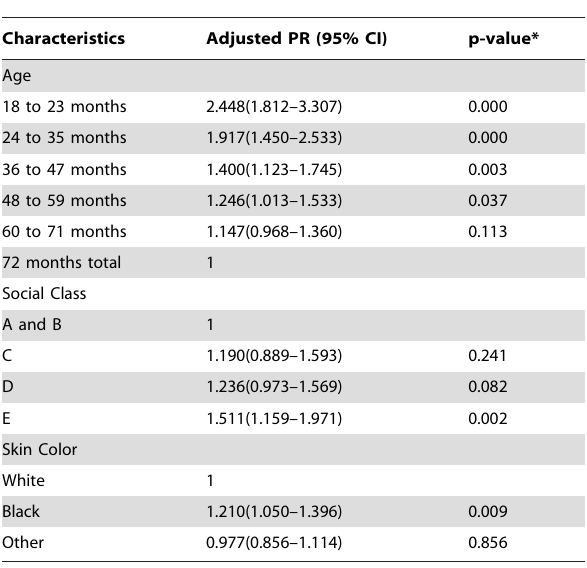
Table 3. Hierarchic Multiple Poisson Regression analysis of the predicting factors for anemia in children, RS, Southern Brazil, 2006–2007.